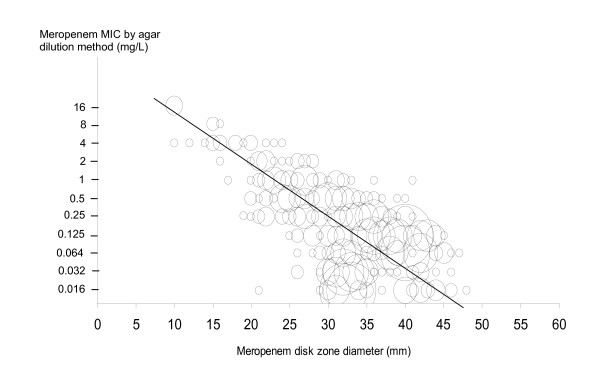
Scattergram comparing meropenem disk zone diameters and log MICs by using agar dilution method for 725 strains (EUCAST values). Minor errors figure in full circles.